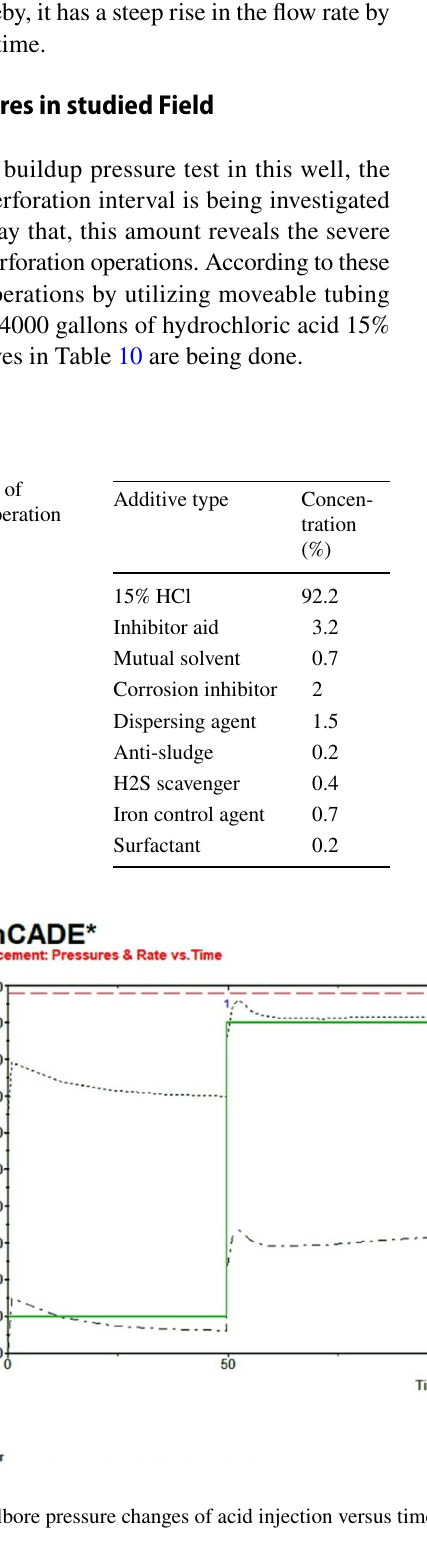
Fig. 6 Surficial and wellbore pressure changes of acid injection versus